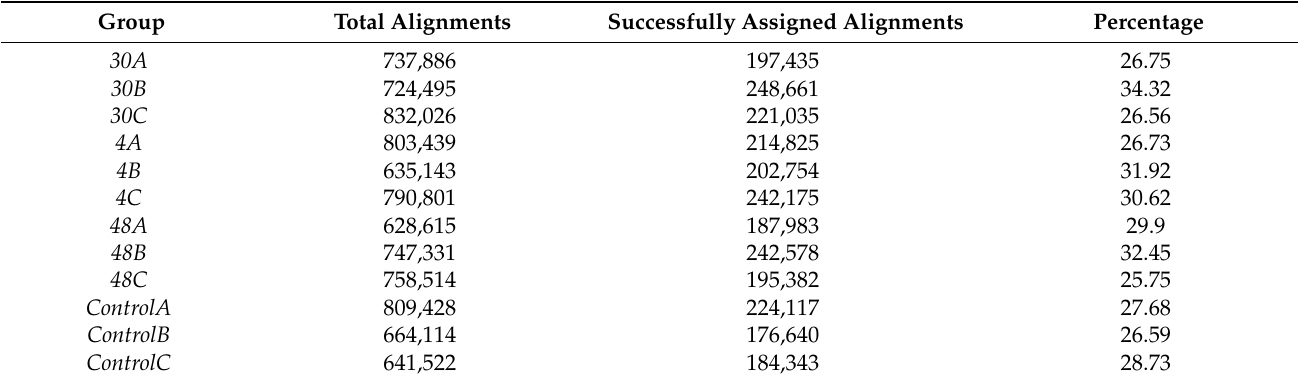
Table 1. Alignment details of the libraries used in the